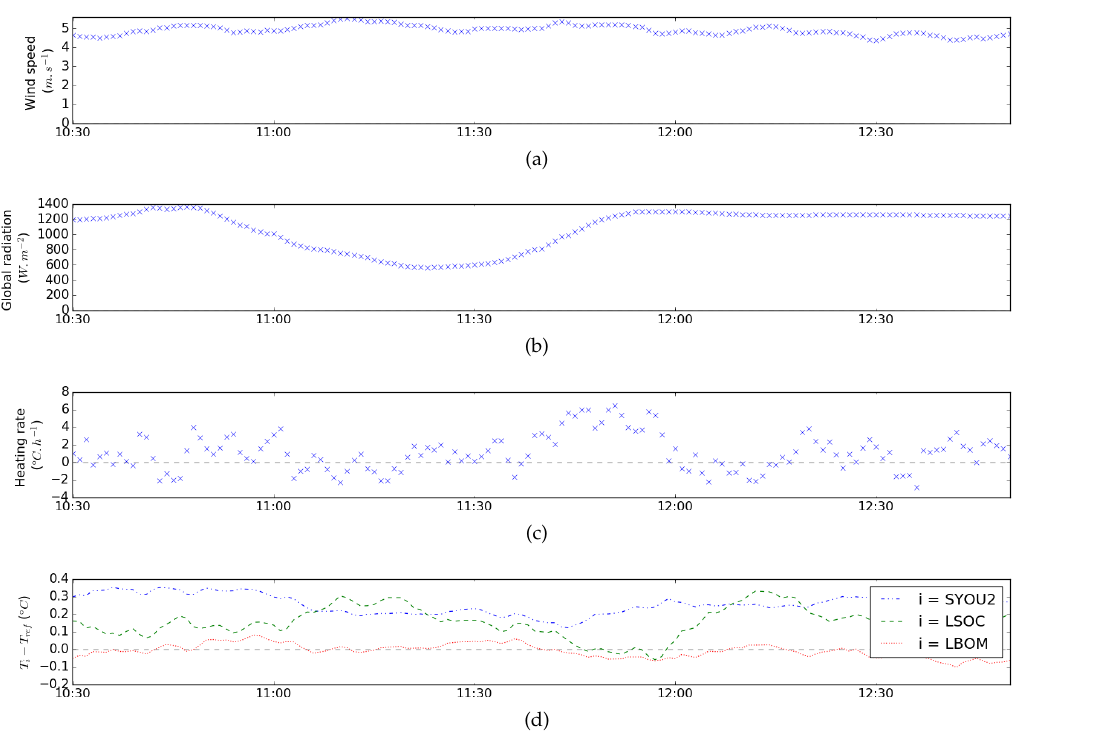
Figure 11. Evolution of the ( a ) wind speed, ( b ) short-wave radiation, ( c ) heating rate and ( d ) air temperature error within several shelters in 16 August